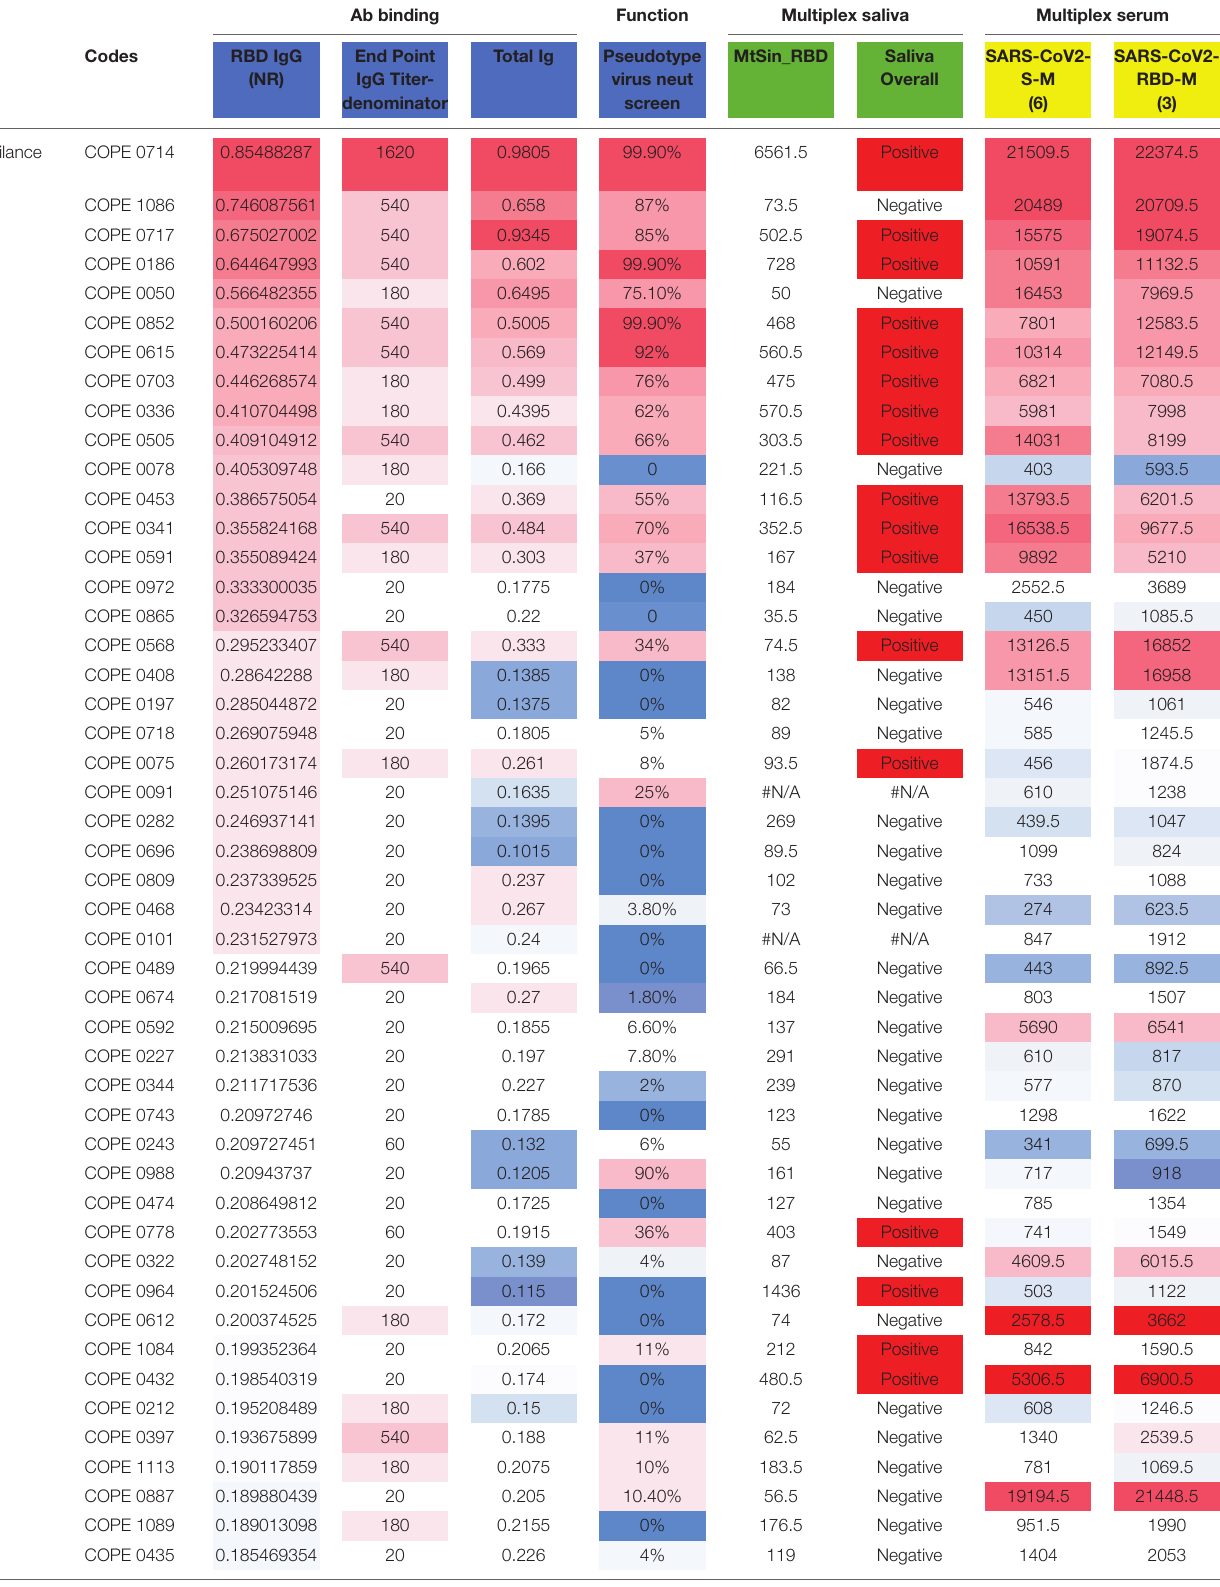
TABLE 3 | Orthogonal